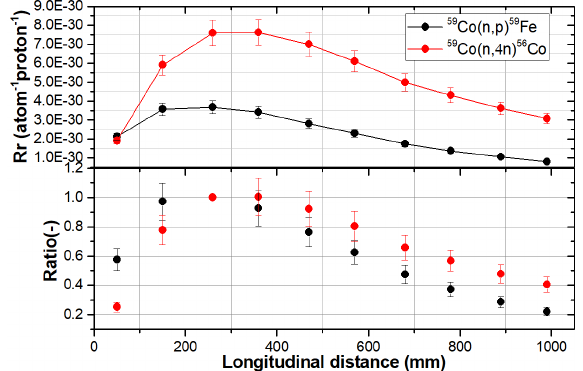
Figure 3. Determination and comparison of 59 Co ( n , p ) 59 Fe , and 59 Co ( n , 4 n ) 56 Co reaction rates at carbon